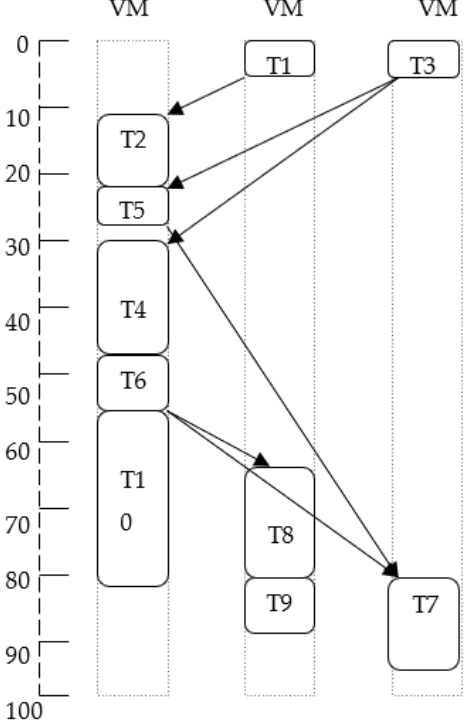
Figure 5. Scheduling of DAG with modified HEFT algorithm (use of maximum computation cost in rank calculation). The schedule length is 96.